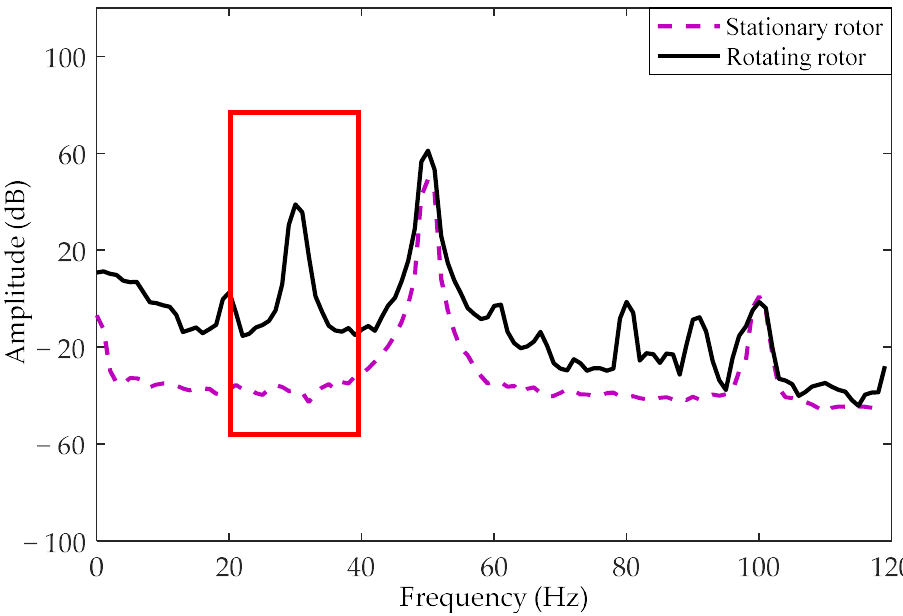
Figure 12. The output signal spectrum under both stationary and rotating conditions.